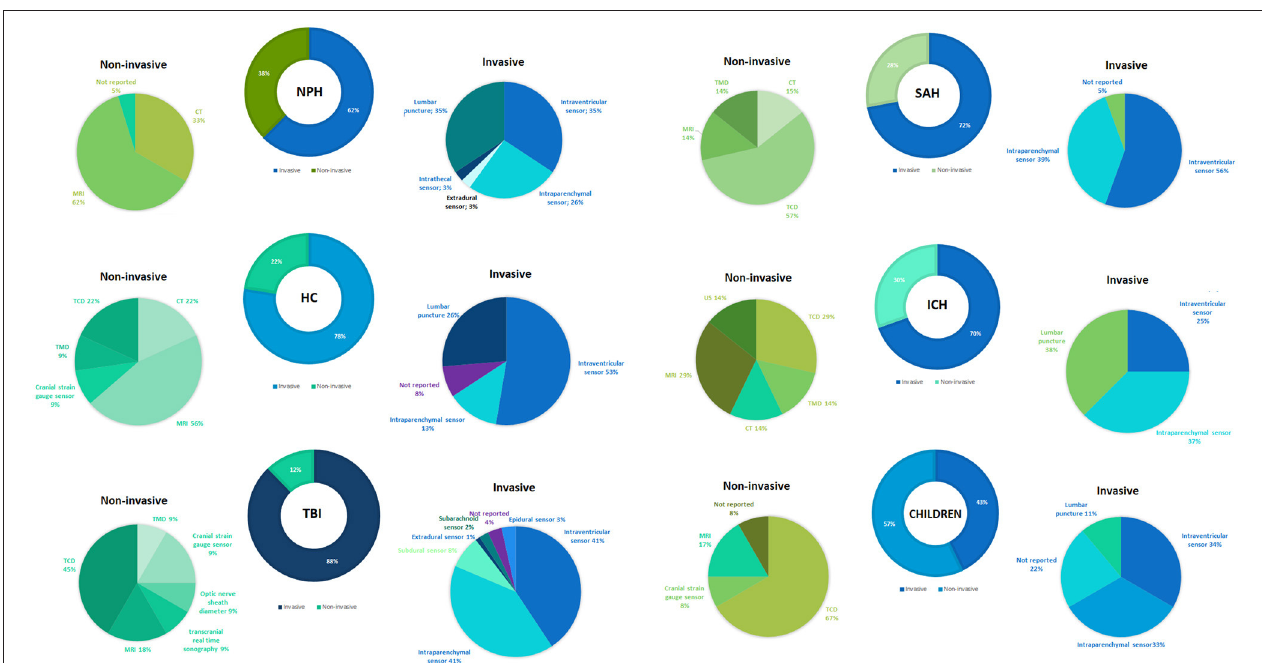
FIGURE 3 | Most frequently reported methods and techniques for the assessment of intracranial compliance.